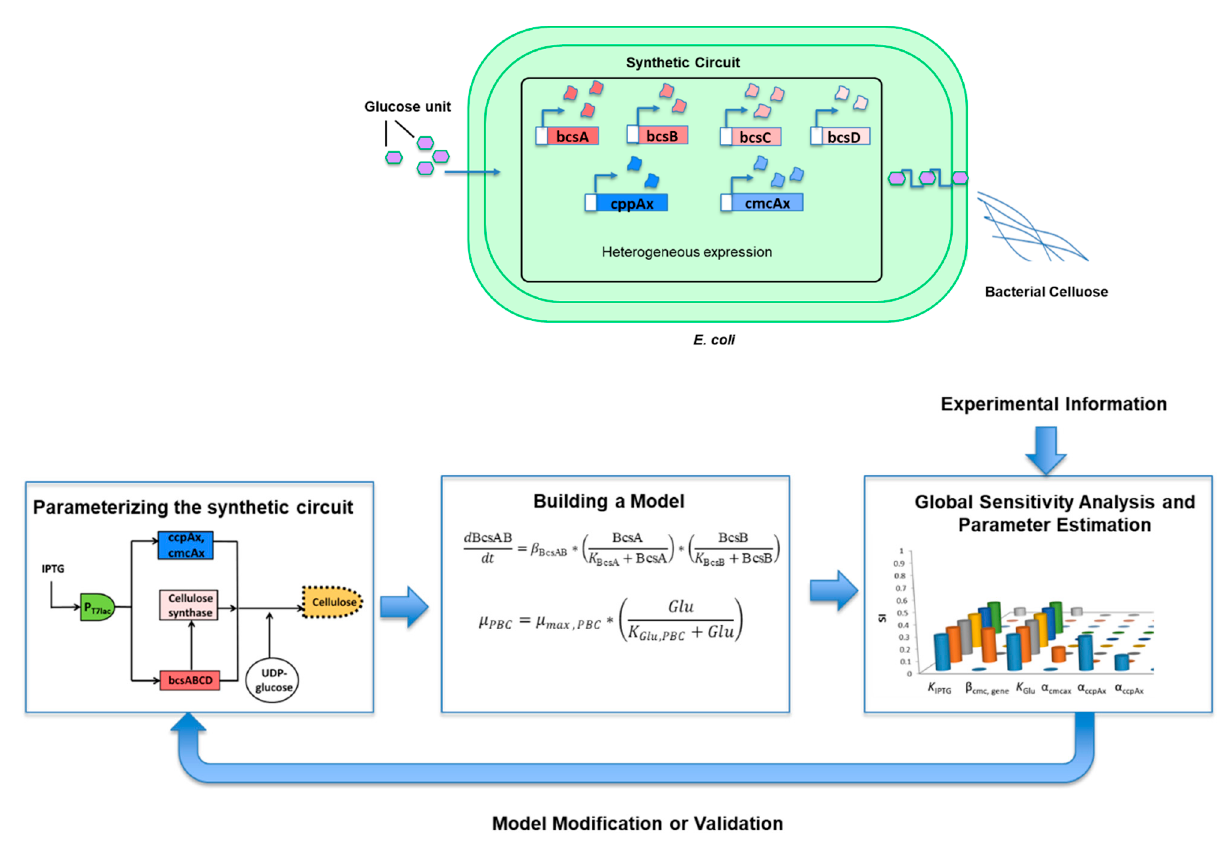
Figure 2. Schematic representation of the synthetic circuit modeling of the BC biosynthetic pathway [77].